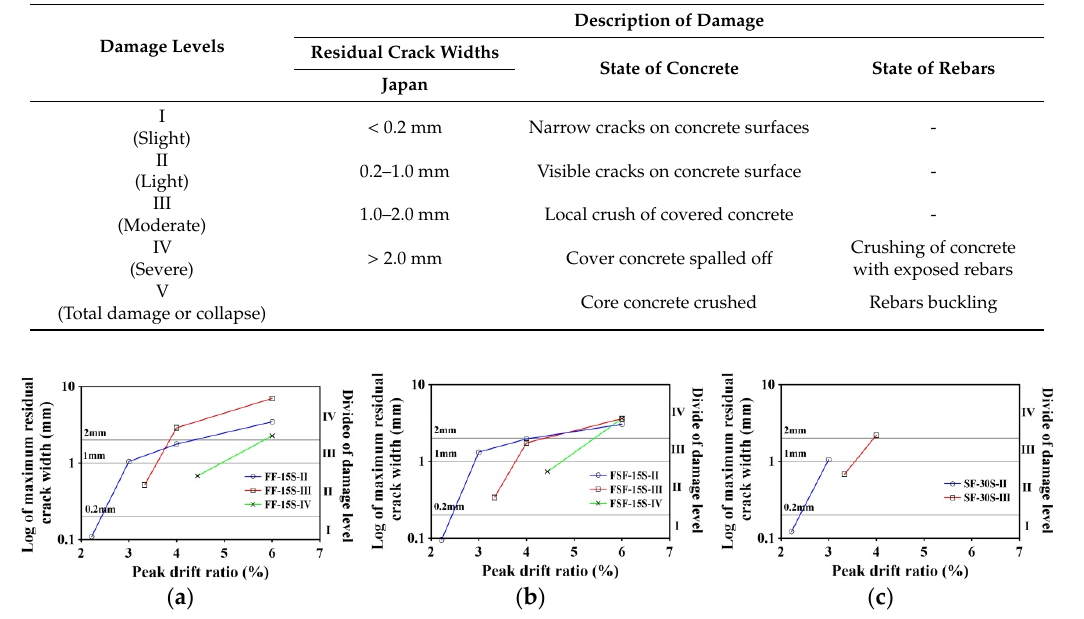
Table 4. Definition of damage levels in JBDPA [25,26].